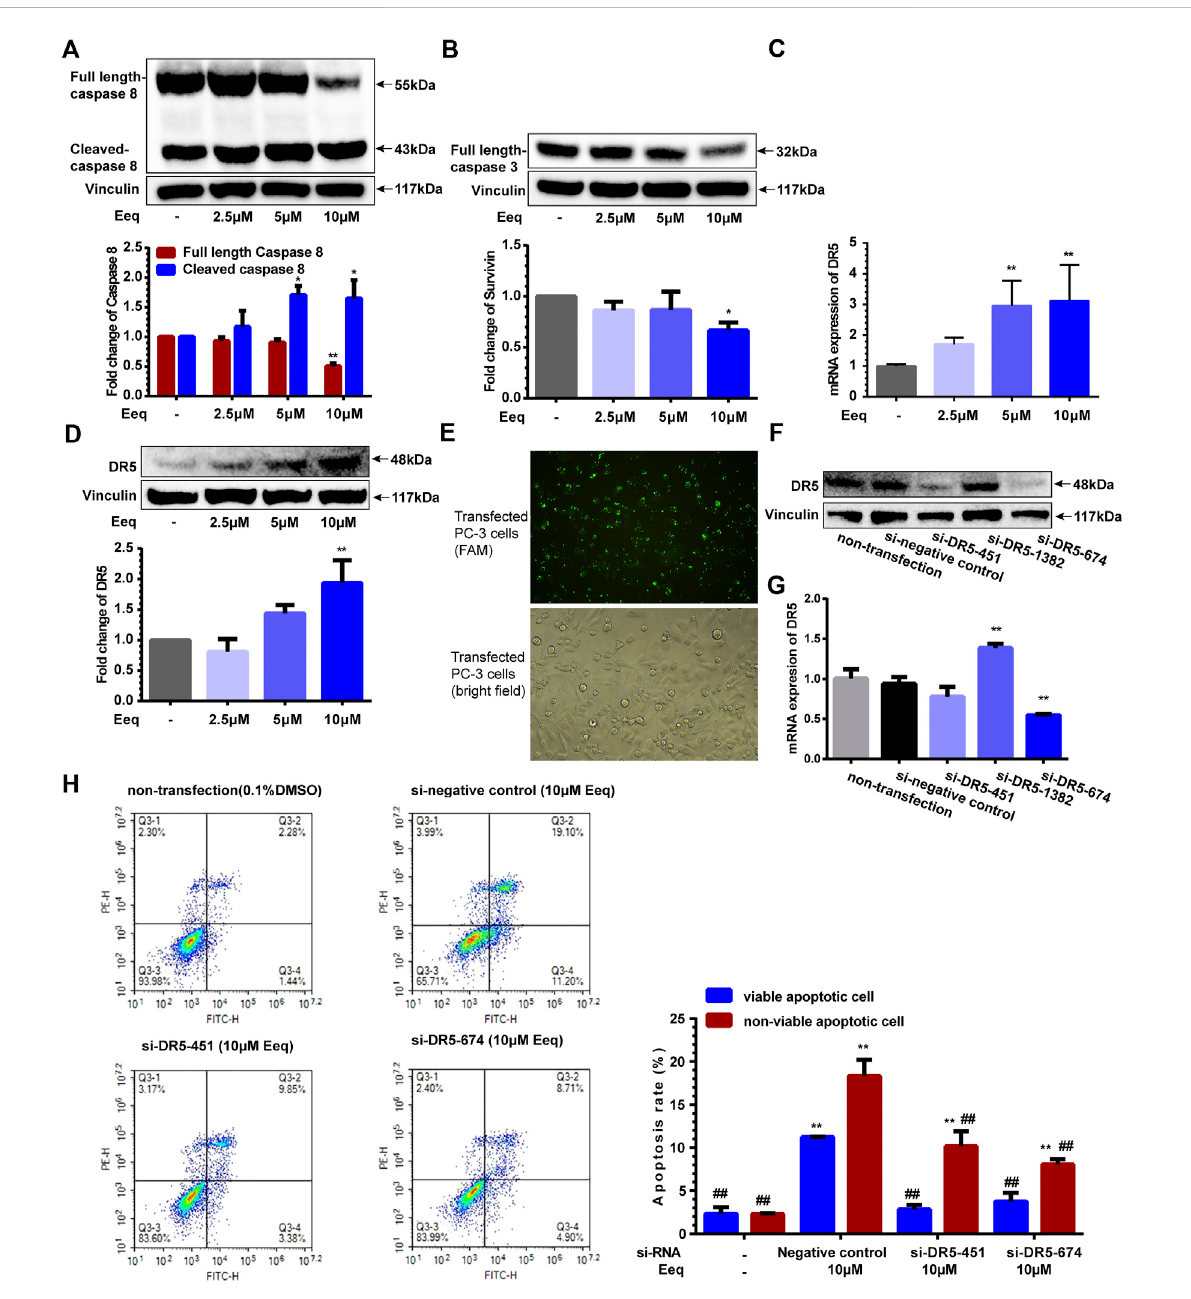
FIGURE 5 5 ′ -Epiequisetin (Eeq) induced PC-3 cell apoptosis by activating the DR5 signaling pathway. (A) Eeq regulated caspase 8 protein expression. (B) Eeq reduced caspase 3 protein expression. (C) Eeq increased mRNA expression of DR5. (D) Eeq increased protein expression of DR5. (E) PC-3 cells were transfected with small interfering RNA. (F) Small interfering RNA knocked down DR5 protein expression. (G) Small interfering RNA knocked downDR5mRNAexpression. (H) Eeqinducedadecreaseinapoptosis ofPC-3 cellsafter DR5wasknockeddownbysmallinterfering RNA.* p < 0.5, ** p < 0.01 vs . control; # p < 0.5, ## p < 0.01 vs . negative control